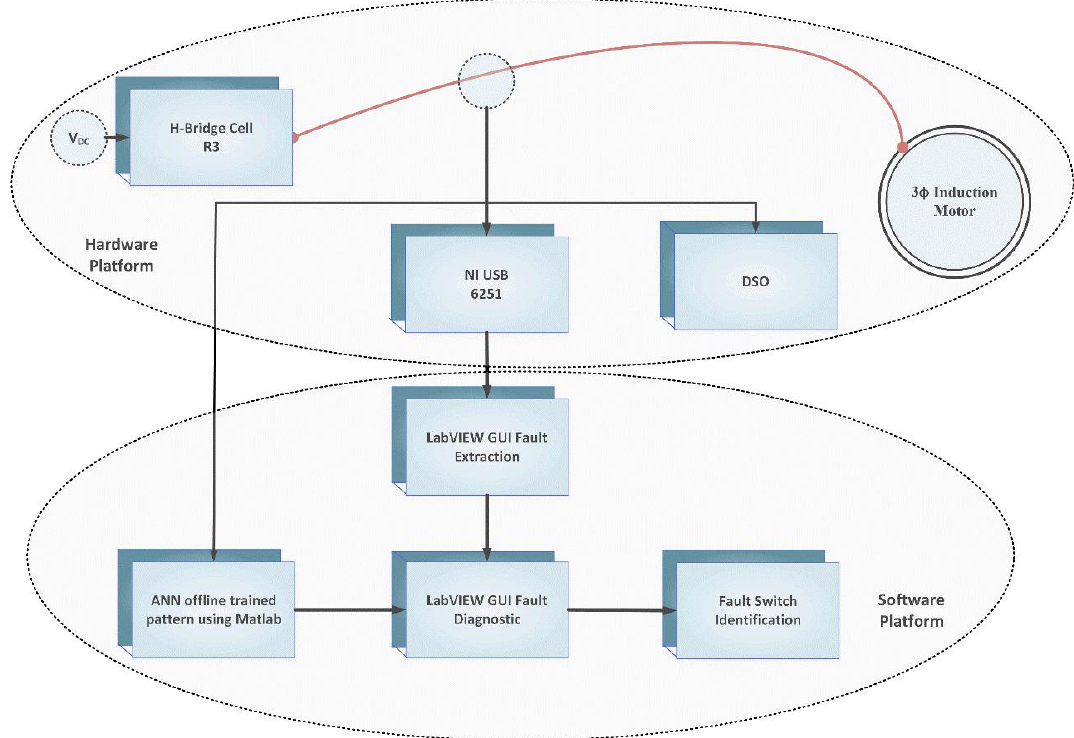
Figure 12. Implementation of the overall fault analytical